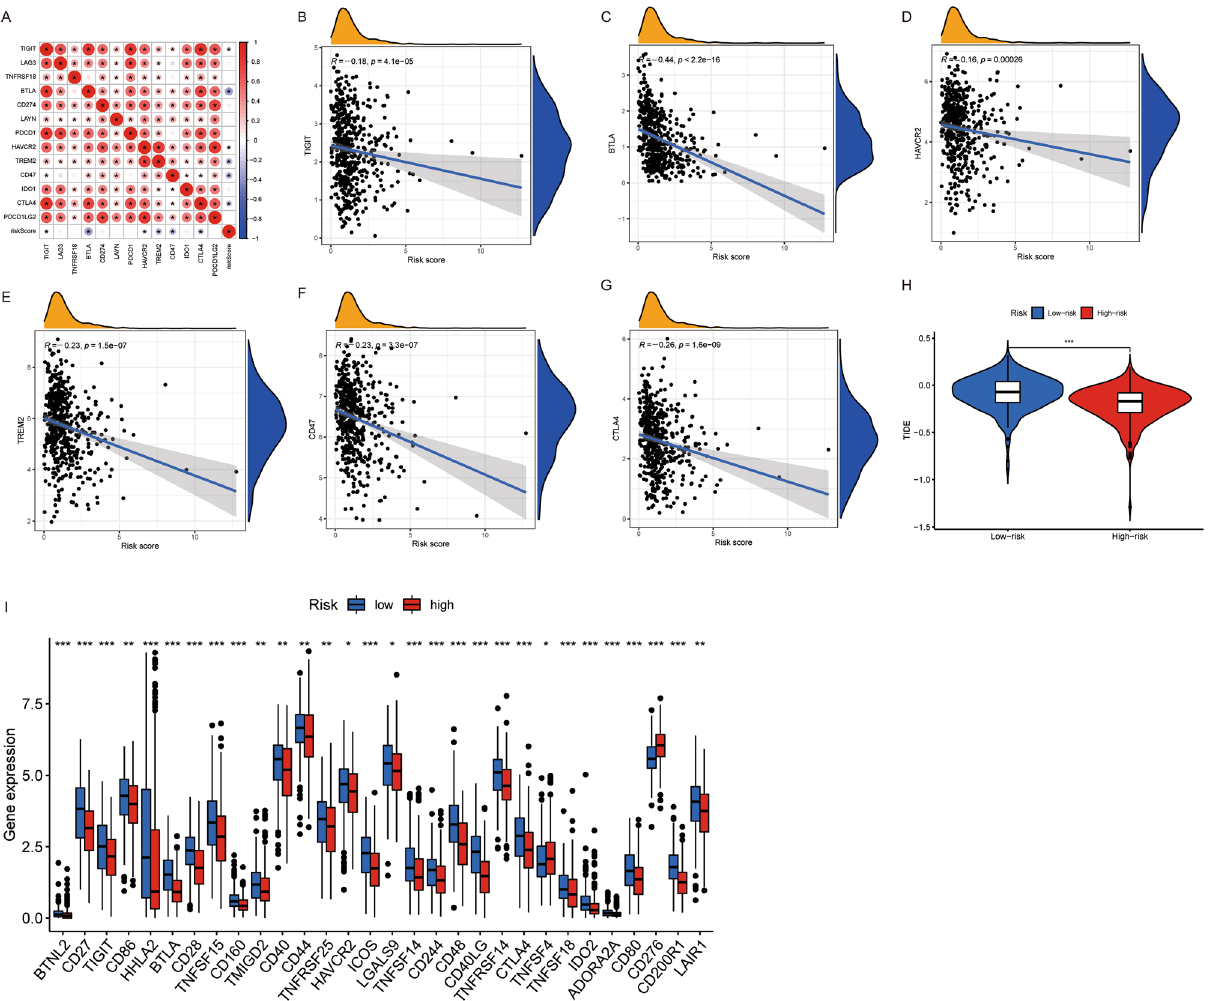
Figure 7. The association between risk score and immune checkpoints. ( A ) The correlation between critical immune checkpoint-related genes and risk score; Red color depicts a positive correlation, while blue color represents a negative correlation. The darker color intensity and larger circle represent a stronger correlation. * indicates p < 0.05, the correlation is significant. ( B – G ) Scatter plots and straight regression lines demonstrated the correlation between the risk score and significant genes related to immune checkpoints. ( H ) The TIDE score distribution between high- and low-risk groups. ( I ) The expression difference of 47 immune checkpoint-related genes between high- and low-risk